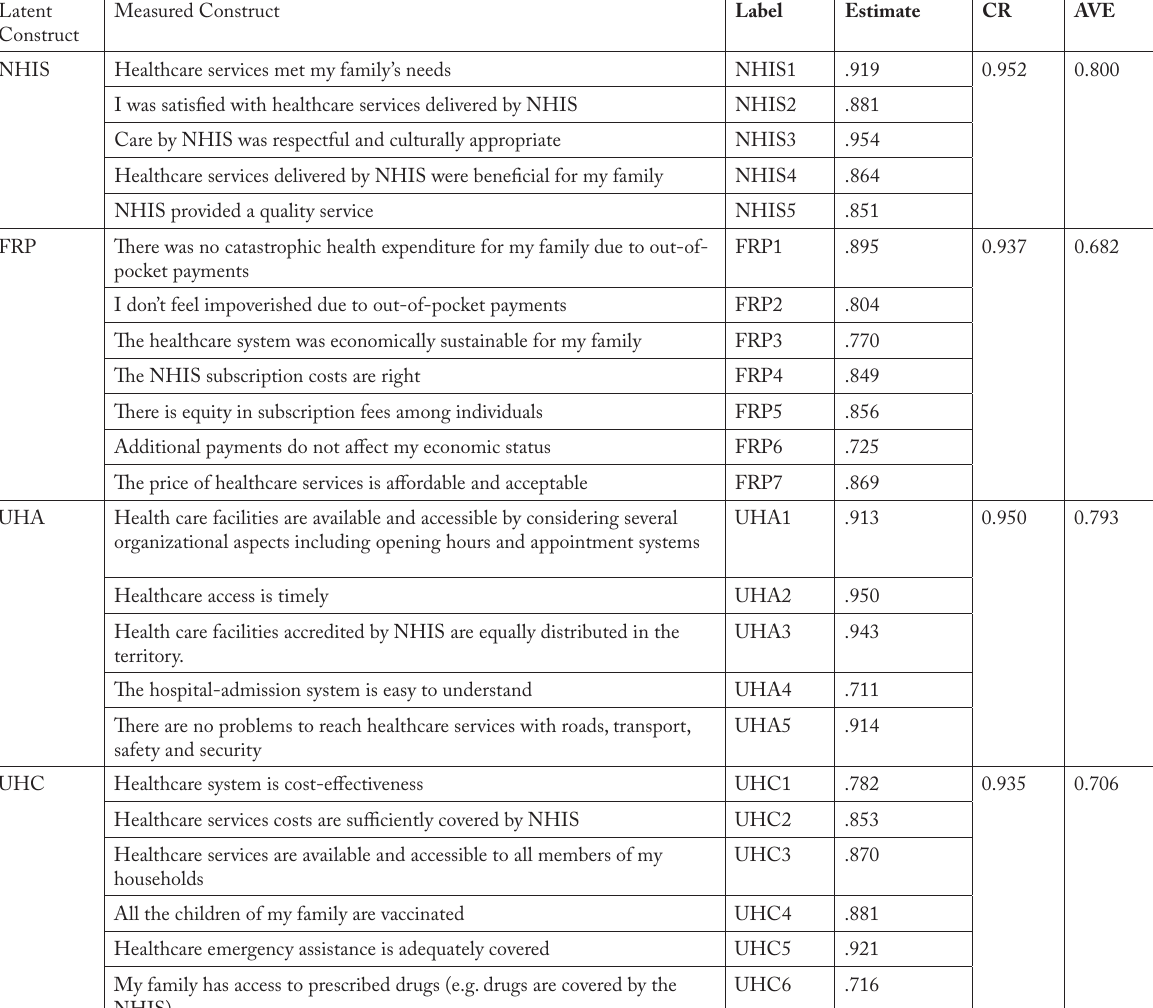
Table 5. Convergent Validity